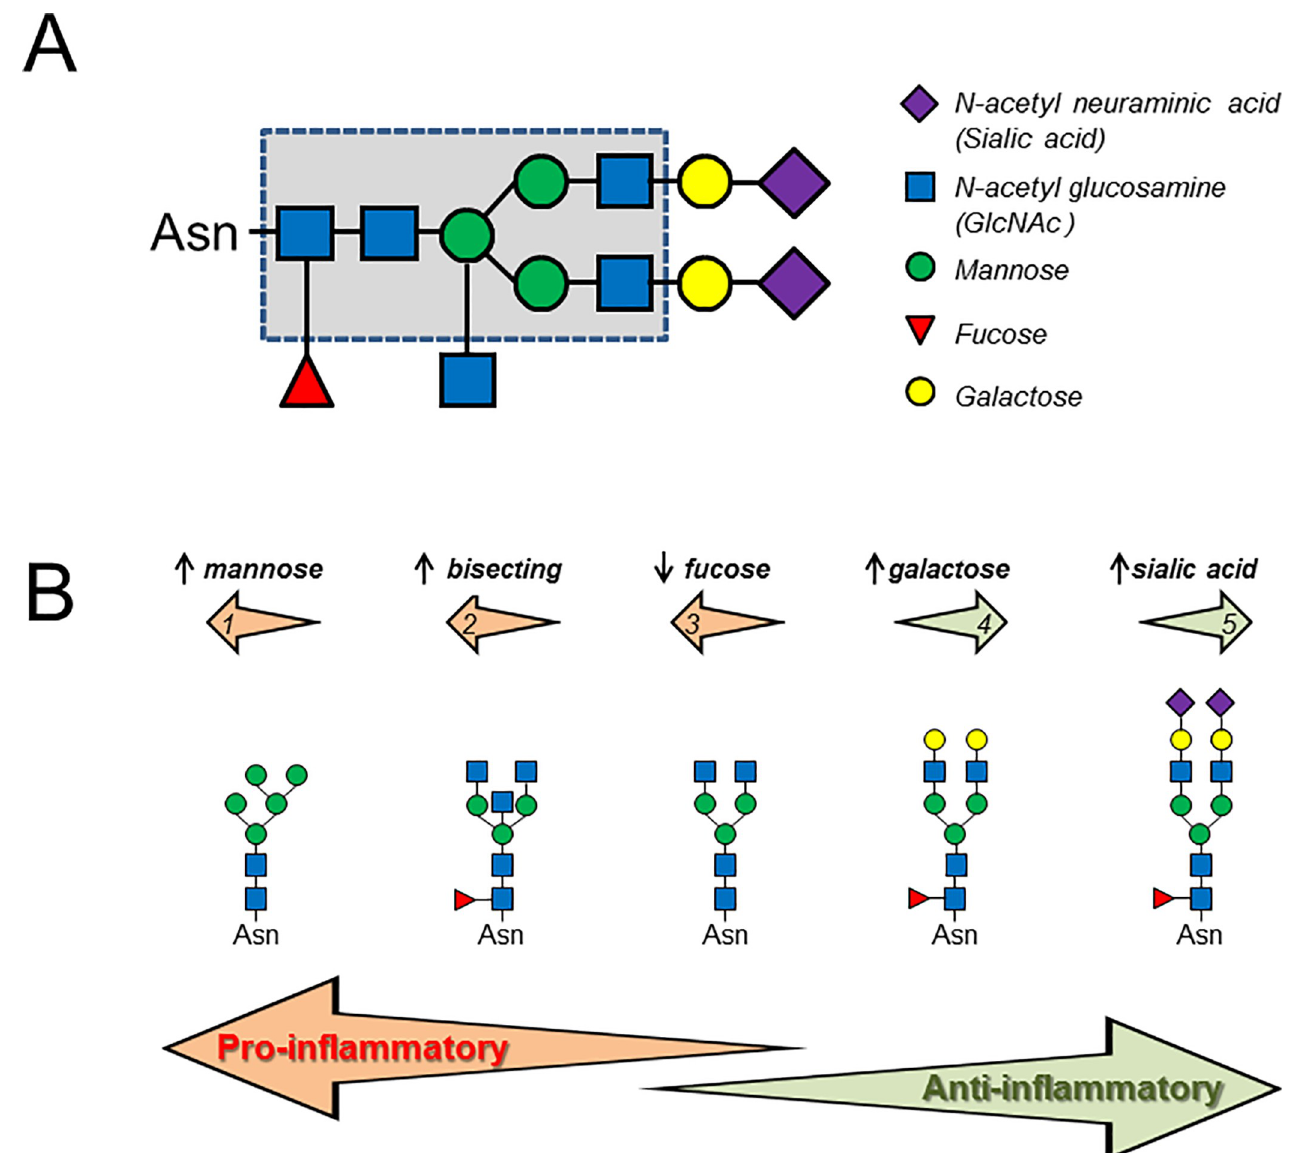
Fig 1. Schematic picture showing IgG Fc N -linked glycans heterogeneity and their downstream effects. A: The N -glycans attached at position Asn297 of IgG Fc fragment are predominantly core-fucosylated bi-antennary structures of the complex type with the arms terminating either with N -acetylglucosamine (Glc N Ac) or N -acetylglucosamine-galactose (Glc N Ac-Gal). The dashed line indicates the conserved heptasaccharide core with possible extensions. B: IgG Fc glycosylation, simplified as five representative structures, can significantly impact effector functions of the IgG molecules. High-mannose N -glycans, bisecting N -acetyl glucosamine (GlcNAc), or absence of core fucose, act mainly pro-inflammatory (arrows 1, 2, and 3, respectively); terminal galactose or sialic residues ( N -acetylneuraminic acid) act mainly anti-inflammatory (arrows 4 and 5, respectively). Symbols and colors are drawn according to the Consortium for Functional